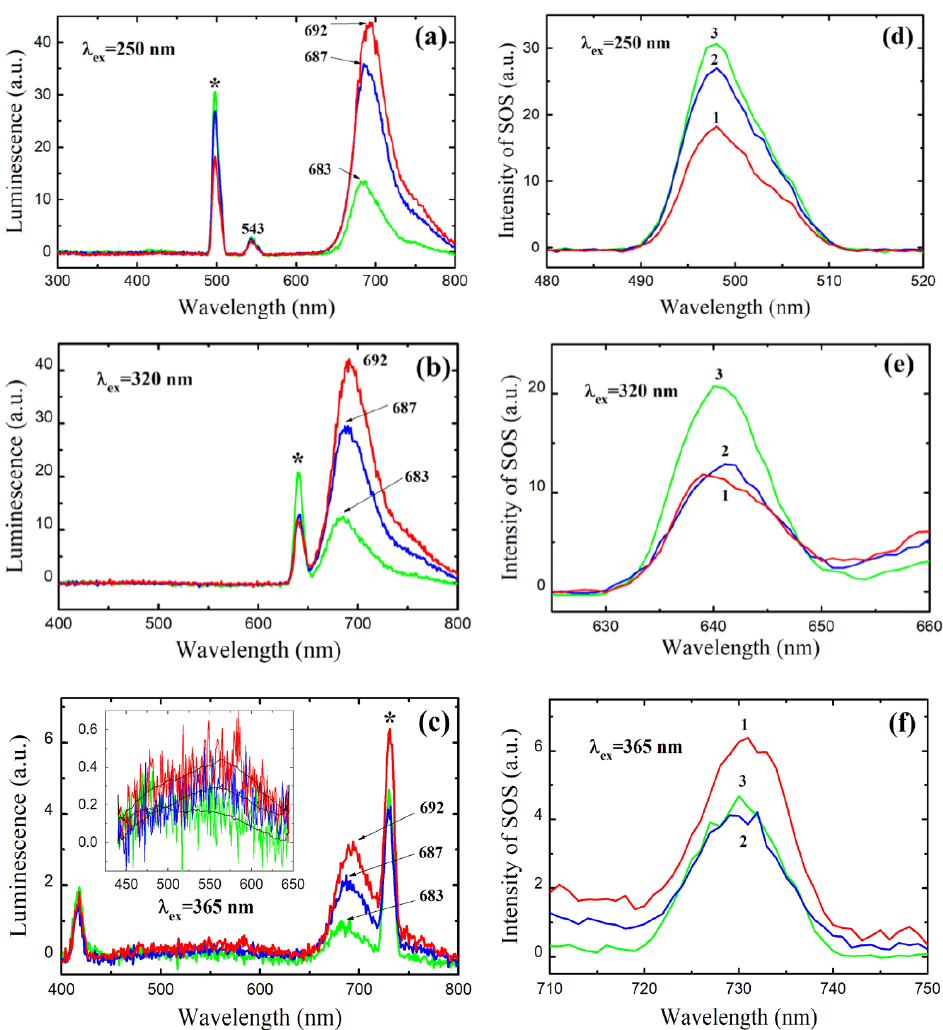
Figure 2. Luminescence spectra ( a – c ) of MB aqueous solutions with MB concentrations of 1 mg · L − 1 (green line), 3.33 mg · L − 1 (blue line), and 5 mg · L − 1 (red line) under excitation wavelengths of 250 ( a ), 320 ( b ), and 365 ( c ) nm. Asterisks mark second-order scattering. Panels ( d – f ) show enlarged peaks of second-order scattering; numbers 1, 2, and 3 correspond to MB concentrations of 5, 3.33, and 1 mg · L − 1 .